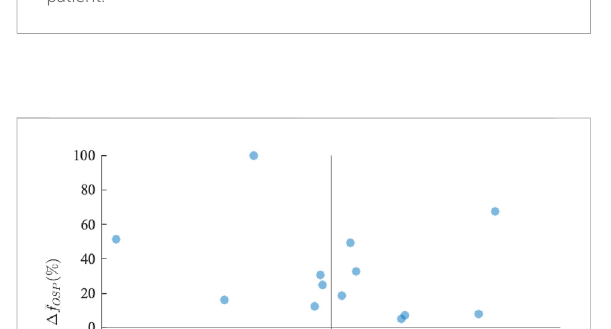
FIGURE 9 Estimates of respiratory f-wave frequency variations Δ f OSPB (black circle) and Δ f OSPD (red p ) from all 1-min segments for each patient.